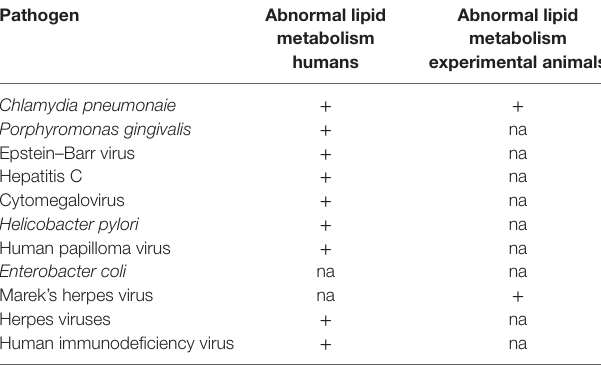
TABle 3 | influence of pathogens on human and experimental animal lipid